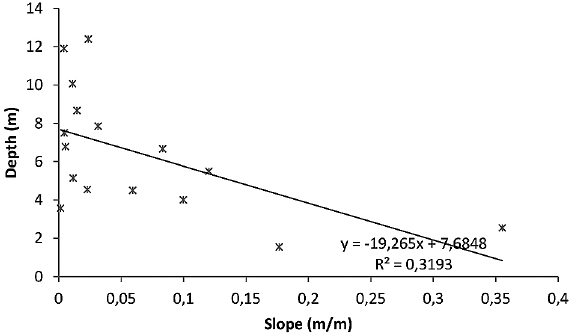
Fig. 8. With higher slope velocity head increases and depth (pressure head) decreases.